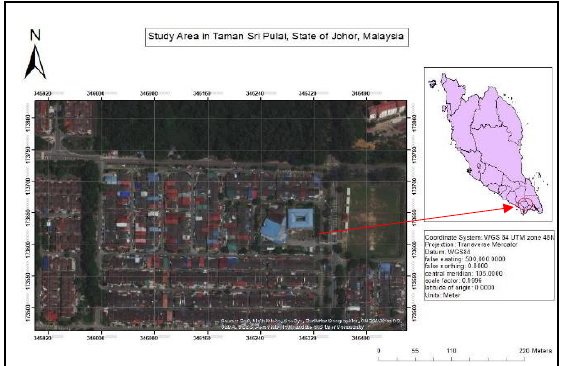
Figure 2 . Location of Study Area at Taman Sri Pulai,